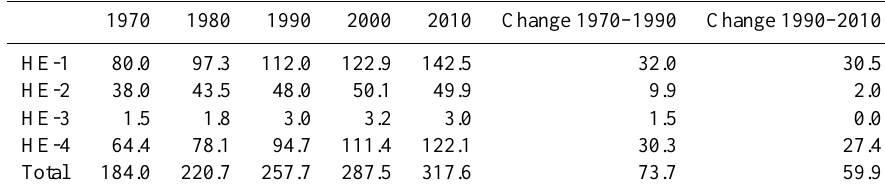
Table A16. Arable land and land under permanent crops (million ha).